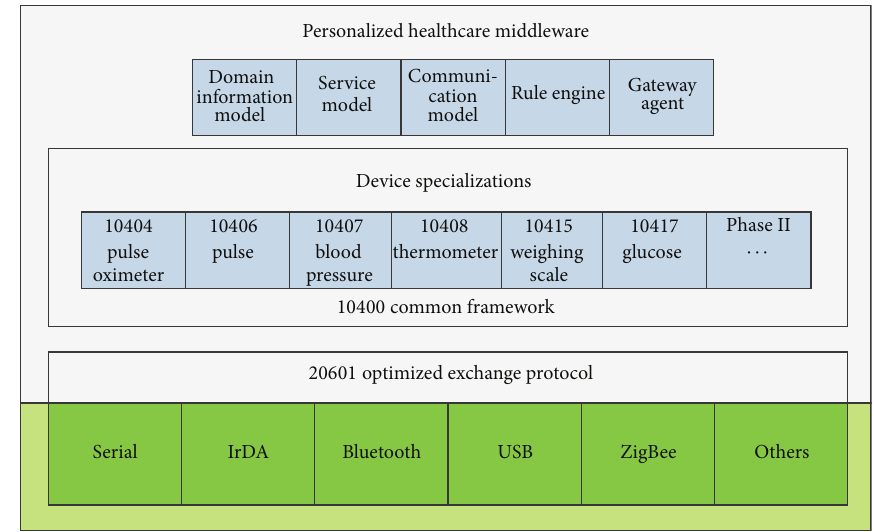
Figure 3: The middleware of the X73 uHealth sensor